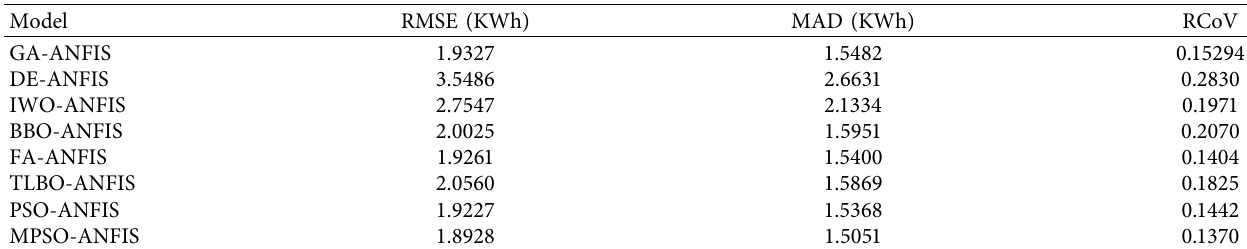
Figure 12: Plot of MPSO-ANFIS model. Table 3: Performance evaluation of the models using statistical performance evaluation